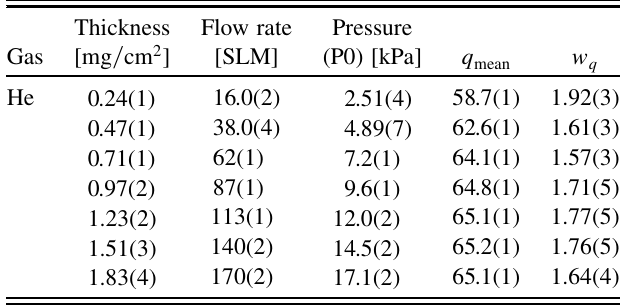
TABLE I. Summary of experimental conditions and charge- state distribution results for the He charge stripper. The given experimental parameters are the gas thickness, gaseous flow rate in SLM, and pressure in the stripping section. The fitting results for the measured charge-state distribution for the mean charge q and the distribution width w q ( 1 (cid:2) ) are listed. mean